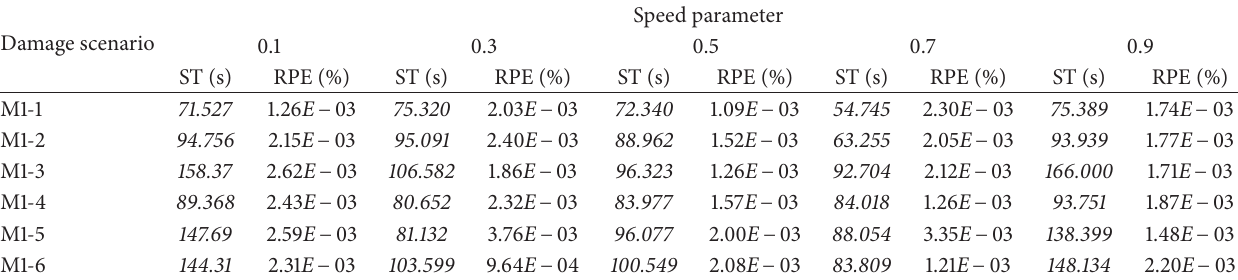
Table 8: Solution time, number of loops, and RPE of ADM method for model 2.